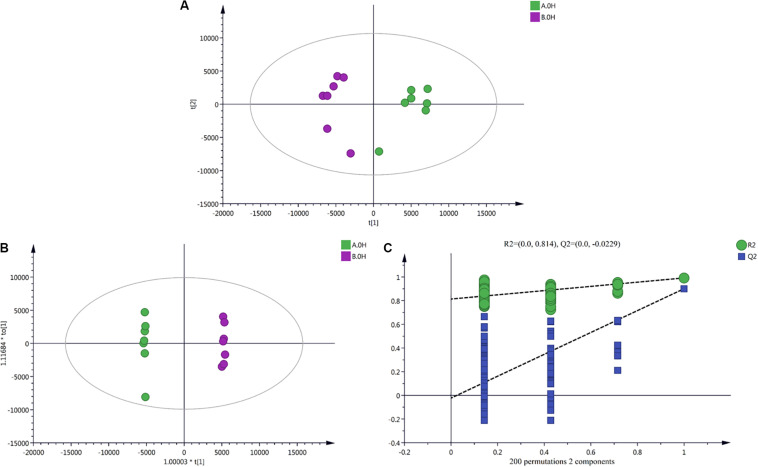
Multivariate analysis charts of V. volvacea samples. (A) PCA shot chart; (B) OPLS-DA analysis results; (C) OPLS-DA replacement inspection results. Two V. volvacea strains treated for 0 h were used as an example group; the results for strain V23 are shown in green, and those for strain VH3 are shown in purple. See supplementary data for the results for other treated groups at 2, 4, 8, and 10 h.